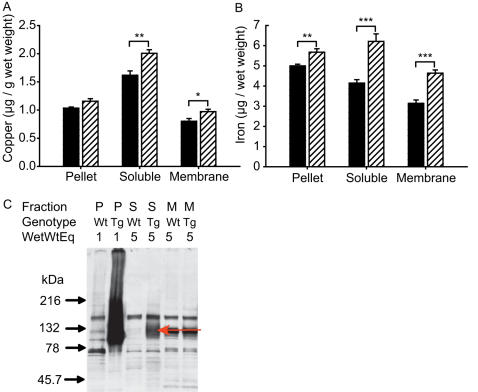
Mutant huntingtin, copper and iron distribution in biochemical fractions of 12-week-old HD mouse cerebral cortex. A. Copper is increased in soluble and membrane fractions. B. Iron is increased in soluble, membrane and pellet fractions. Metals were measured by ICP-MS. n = 10–11. p-values after Dunn-Šidák correction for multiple testing *<0.05, **<0.01, ***<0.001 C. Distribution of mutant huntingtin in pellet (P), soluble (S) and membrane (M) fractions as determined by Western blotting using a polyglutamine specific antibody (IC2-Chemicon). Pellets were treated with 90% formic acid for 1 hour at 37°C, lyophilized then resuspended in SDS-PAGE buffer. Mutant huntingtin is identified by the presence of a band in transgenic mice (Tg) but not wild-type (Wt) mice (red arrow for soluble fraction). WetWtEq = wet weight equivalents.